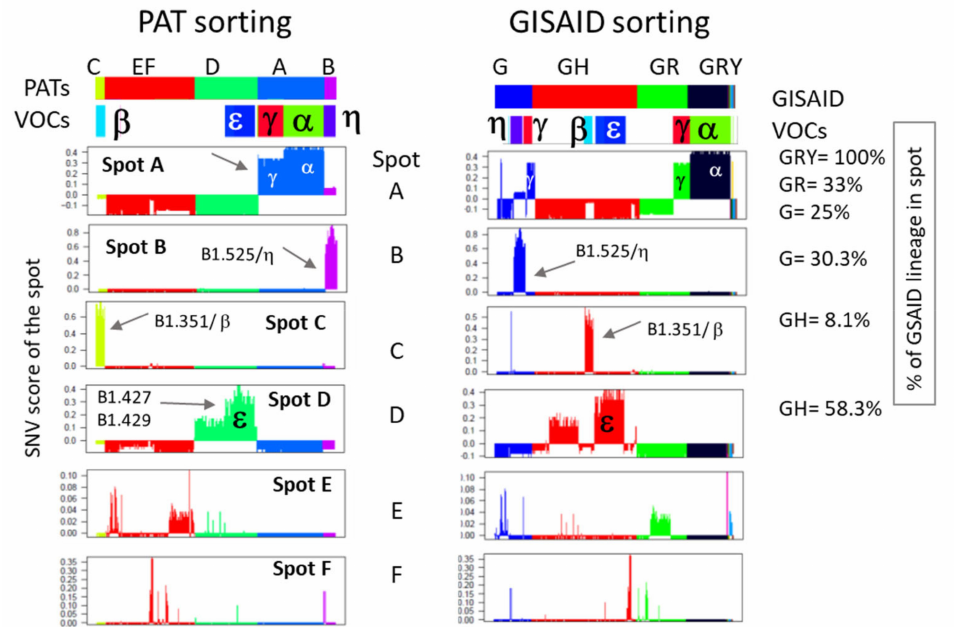
Figure A6. Spot SNV-profiles across the variants sorted and colored using PAT ( left ) and GISAID ( right ) classes. WHO VOC/VOI classes are indicated by the second color bar to link both sides. VOC/VOI classes uniquely assign to PATs except PAT A which splits into VOCs alpha and gamma. In contrast, the relation between GISAID and VOC/VOI groups is fuzzier. For example, gamma splits between GISAID GR and GH, which, in turn, contains also epsilon and